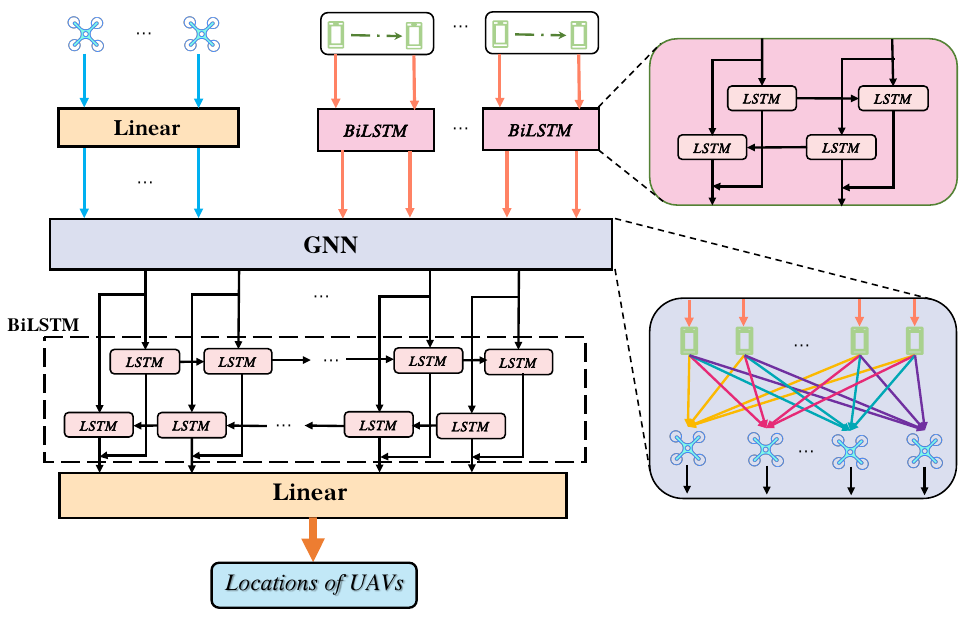
Figure 4. The structure of